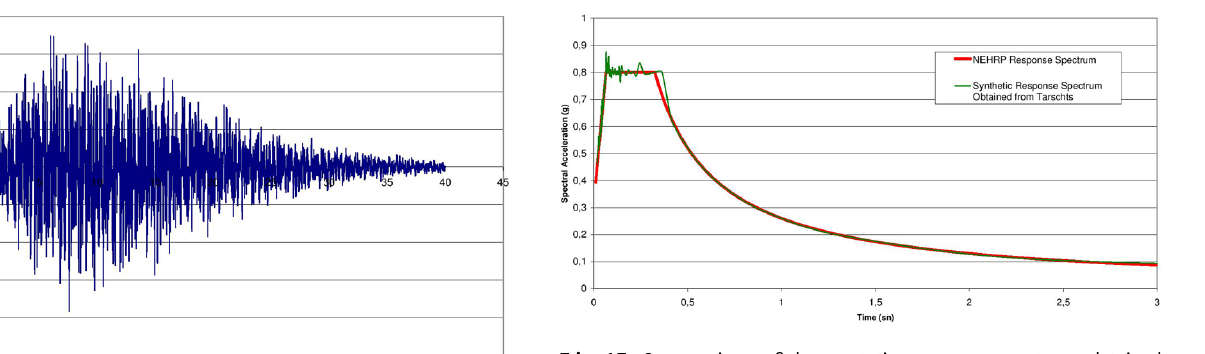
Fig. 17. Comparison of the syntetic response spectrum obtained from TARSCHTS and NEHRP response spectrum for the A18 cell (˙Ince,